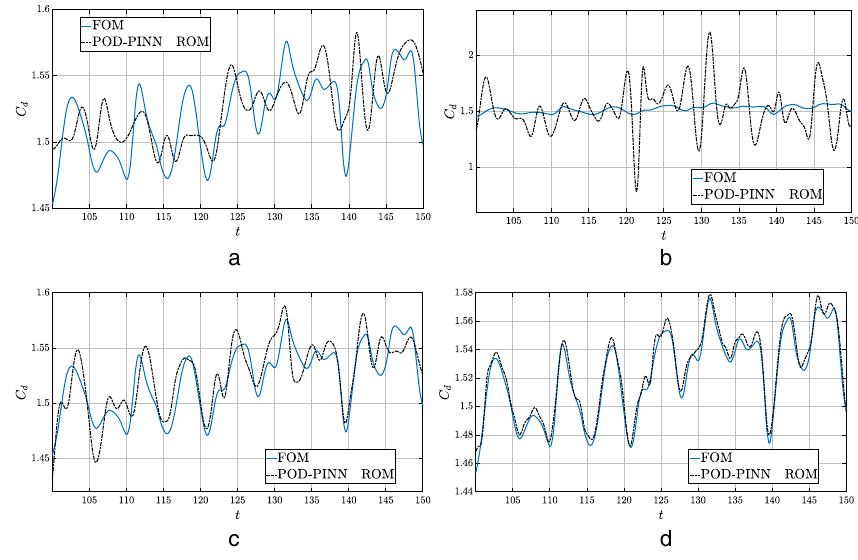
Fig. 16 The drag coefficients curve over the time range [100 , 150]s. The figures show the one obtained by the FOM solver and the ones approximated by the ROM for different values of and N u , N p and N S . (a) The drag coefficients curve reconstructed by the ROM using N u = N p = N S = 10 compared to the FOM one. (b) The drag coefficients curve reconstructed by the ROM using N u = N p = N S = 20 compared to the FOM one. (c) The drag coefficients curve reconstructed by the ROM using N u = N p = N S = 30 compared to the FOM one. (d) The drag coefficients curve reconstructed by the ROM using N u = N p = N S = 60 compared to the FOM one